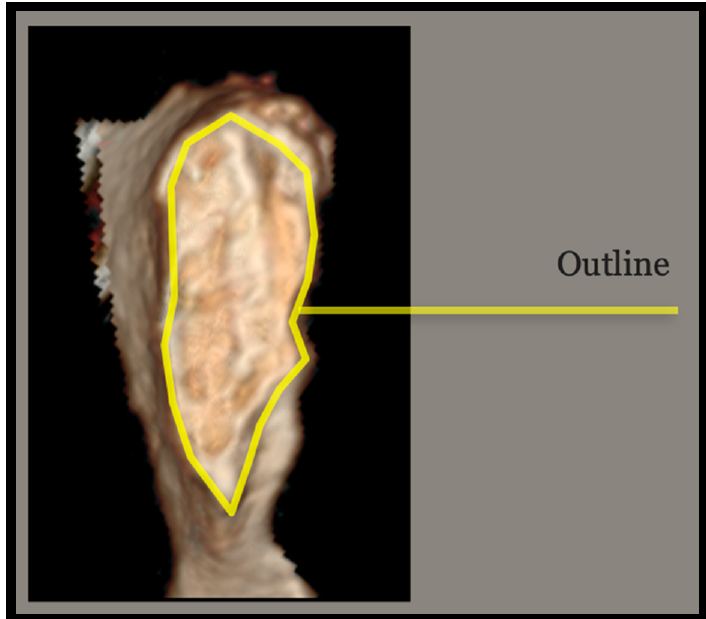
Figure 6. The Outline.